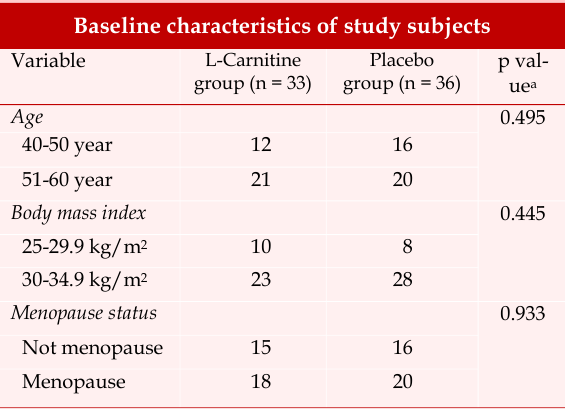
Baseline characteristics of study subjects